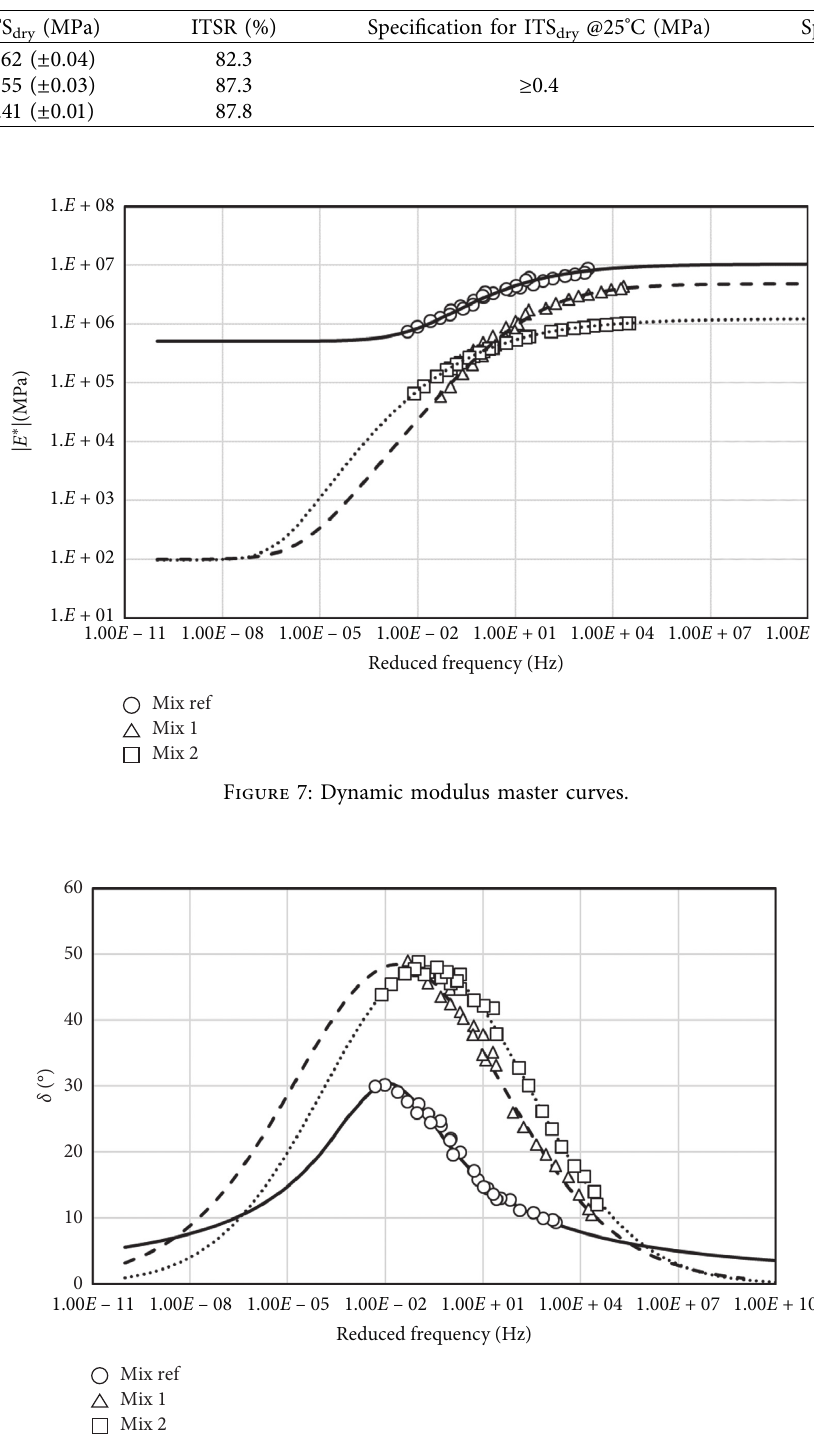
Table 4: ITS test results.